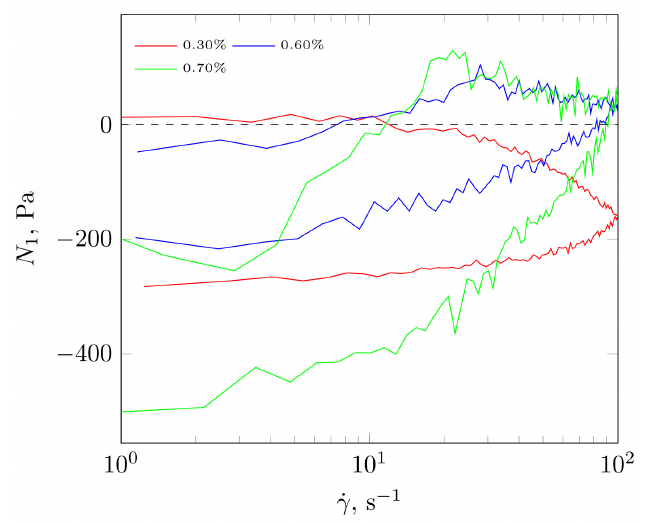
Figure 7. First normal stress difference as a function of shear rate for extracts with the highest concentration at 25 °C.